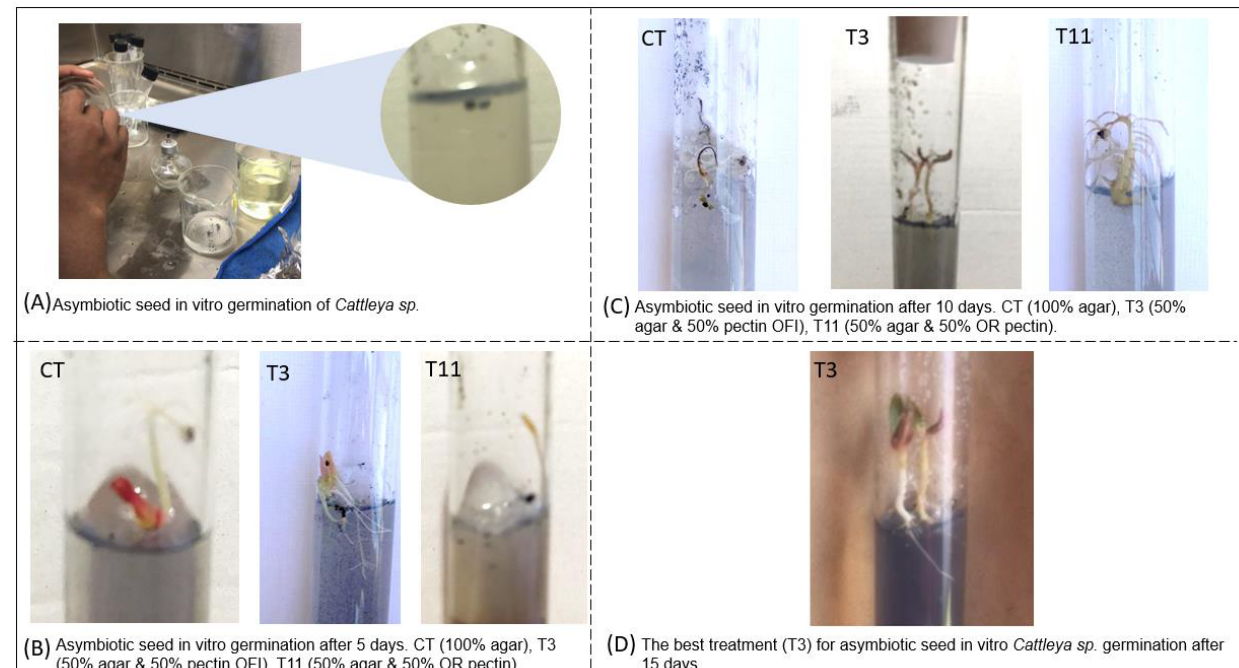
Figure 3. Designed Gels of the best treatments. CT (100% agar), T3 (50% agar & 50% pectin OFI), T11 (50% agar & 50% OR pectin). ( A ) Asymbiotic seed in vitro germination of Cattleya sp. ( B ) Asymbiotic seed in vitro germination after five days. ( C ) Asymbiotic seed in vitro germination after ten days. ( D ) T3 after fifteen days.